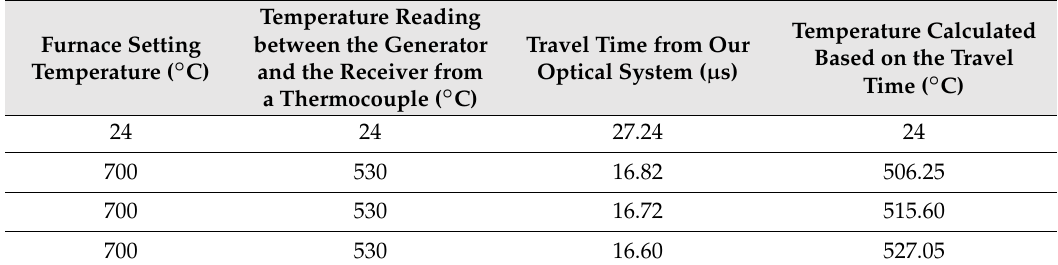
Table 1. The relationship between different temperature results.